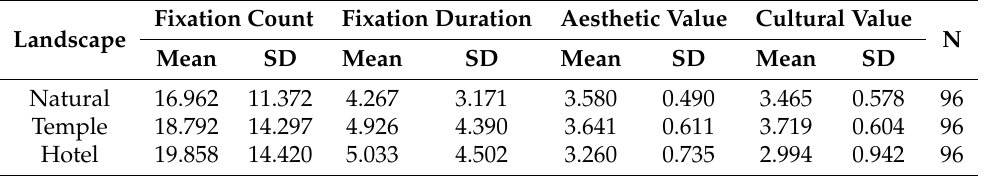
Table 2. Statistical description of three landscapes in terms of eye movement and landscape values.